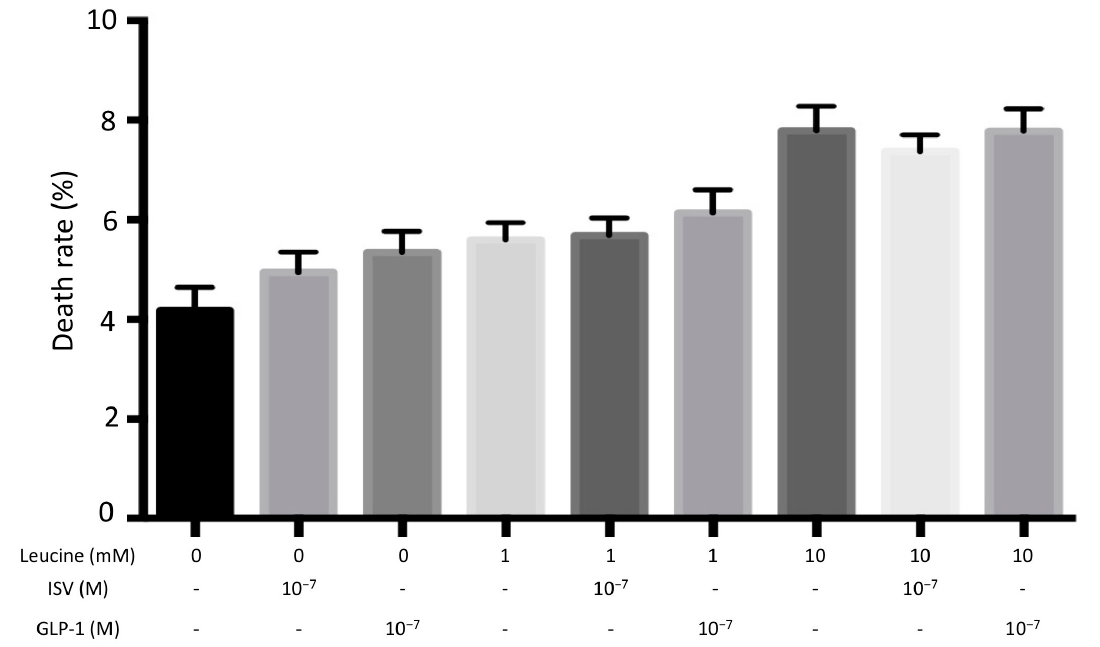
Figure 4. Effects of 10 − 7 M ISV and 10 − 7 M GLP-1 on cell death rate in leucine-treated INS-1E cells. We measured cell death rate following 72 h of incubation with or without 10 − 7 M ISV and 10 − 7 M GLP-1, in the medium containing 1 mM or 10 mM leucine. Data are presented as the mean ± SEM of 28 samples per group from three independent experiments.